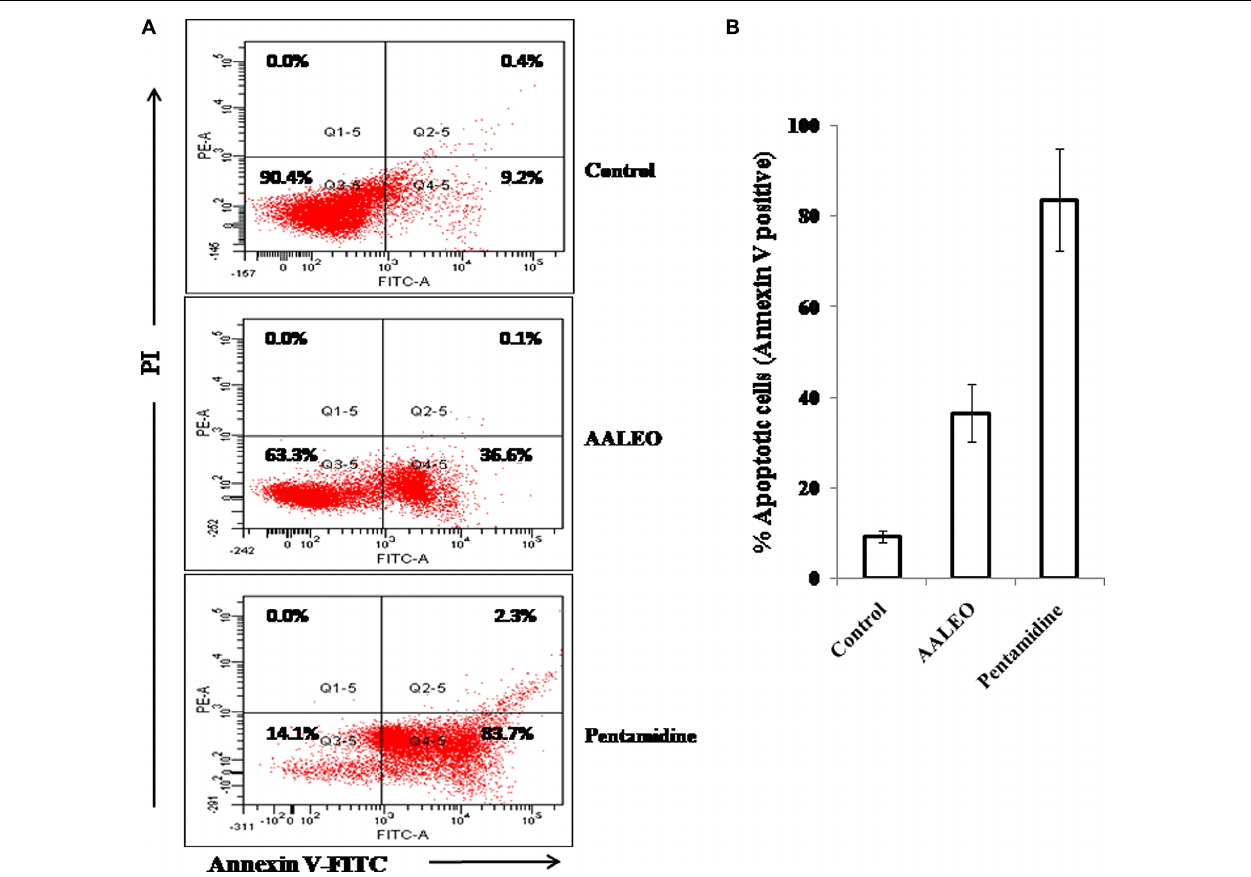
FIGURE 3 | Detection of apoptosis in L. donovani promastigotes by annexinV-FITC and PI co-staining. Parasites were incubated with AALEO or pentamidine (100 μ g ml − 1 ) for 72 h, and analyzed by flow cytometry as